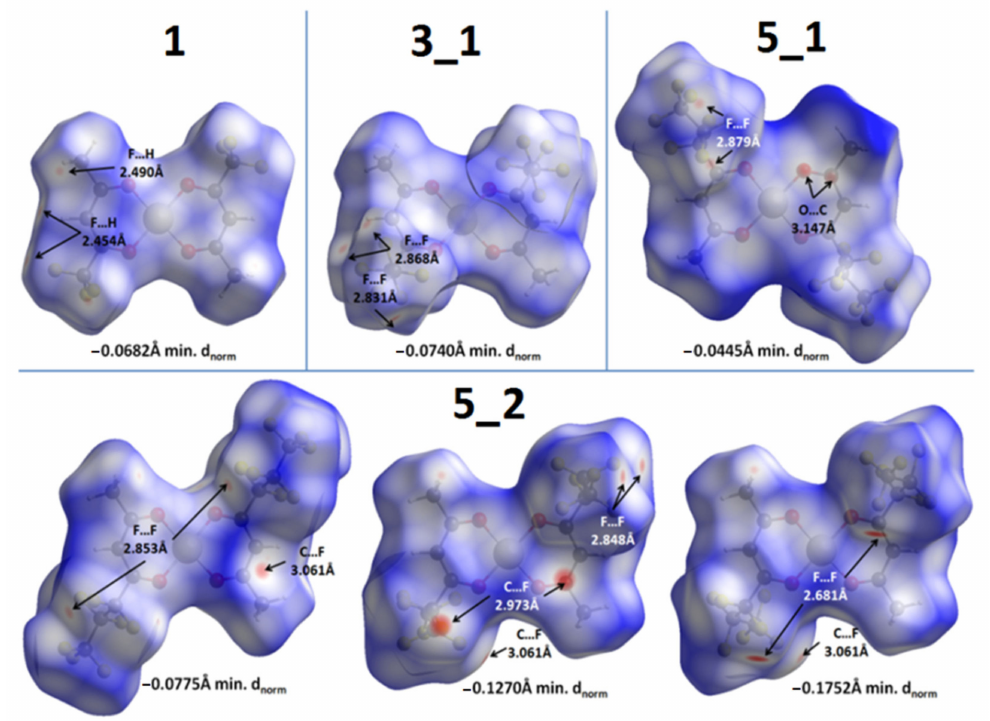
Figure 5. Hirshfeld surfaces for Pd β -diketonates, mapped with the d norm property (range from − 0.18 to